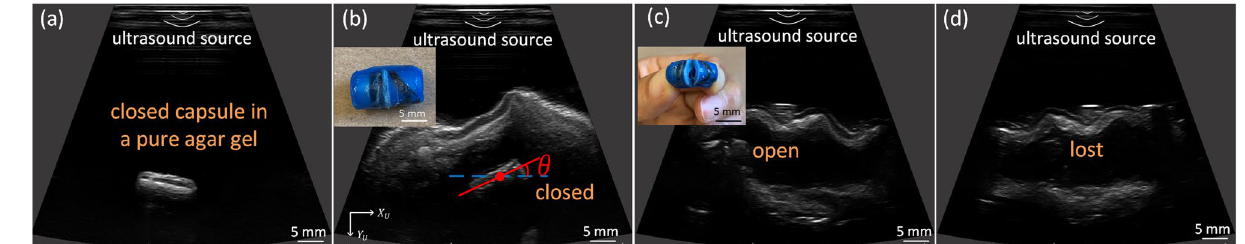
Figure 1. The capsule in a pure agar gel ( a ). In-plane 2D pose and the three mechanism states of the microcapsule including closed, open and lost-in-the- FOV in ultrasound images ( b – d ) acquired in an ex-vivo pig’s stomach. The centroid and orientation of the capsule are shown in ( b ) where the red line shows the orientation with respect to horizontal. The insets show the fabricated closed and open